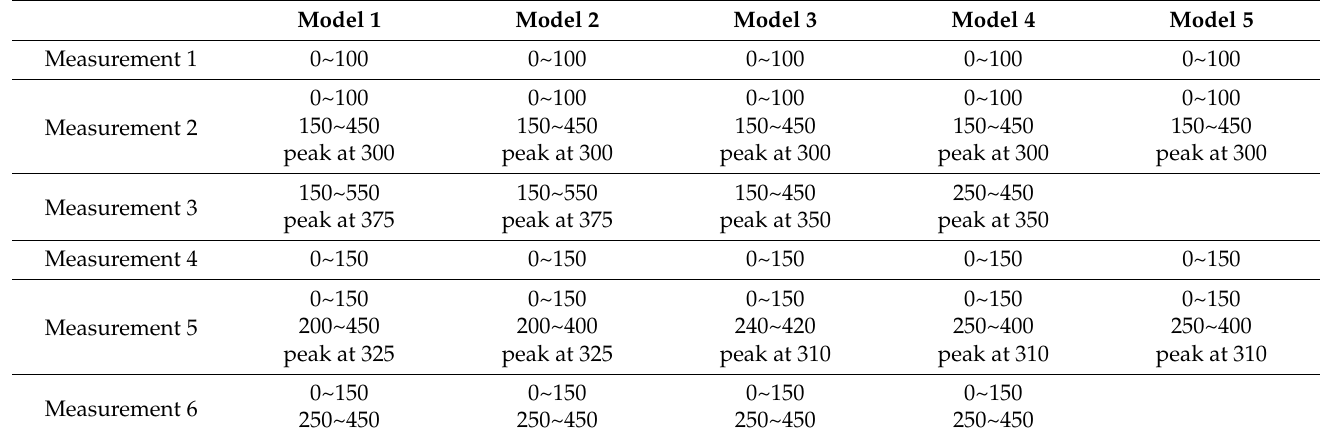
Figure 14. Noise reduction effect for ward construction noise. ( a ) Measurement 1: stethoscope on left leg skin in quiet space. ( b ) Measurement 2: stethoscope on the left leg skin in noise space. ( c ) Measurement 3 on lower leg skin: mic for environmental noise. ( d ) Measurement 4: stethoscope on left chest in quiet environment. ( e ) Measurement 5: stethoscope on left chest in noisy environment. ( f ) Measurement 6 on left chest after noise reduction. Table 2. Frequency bands (in Hz) of different measurements for different models.